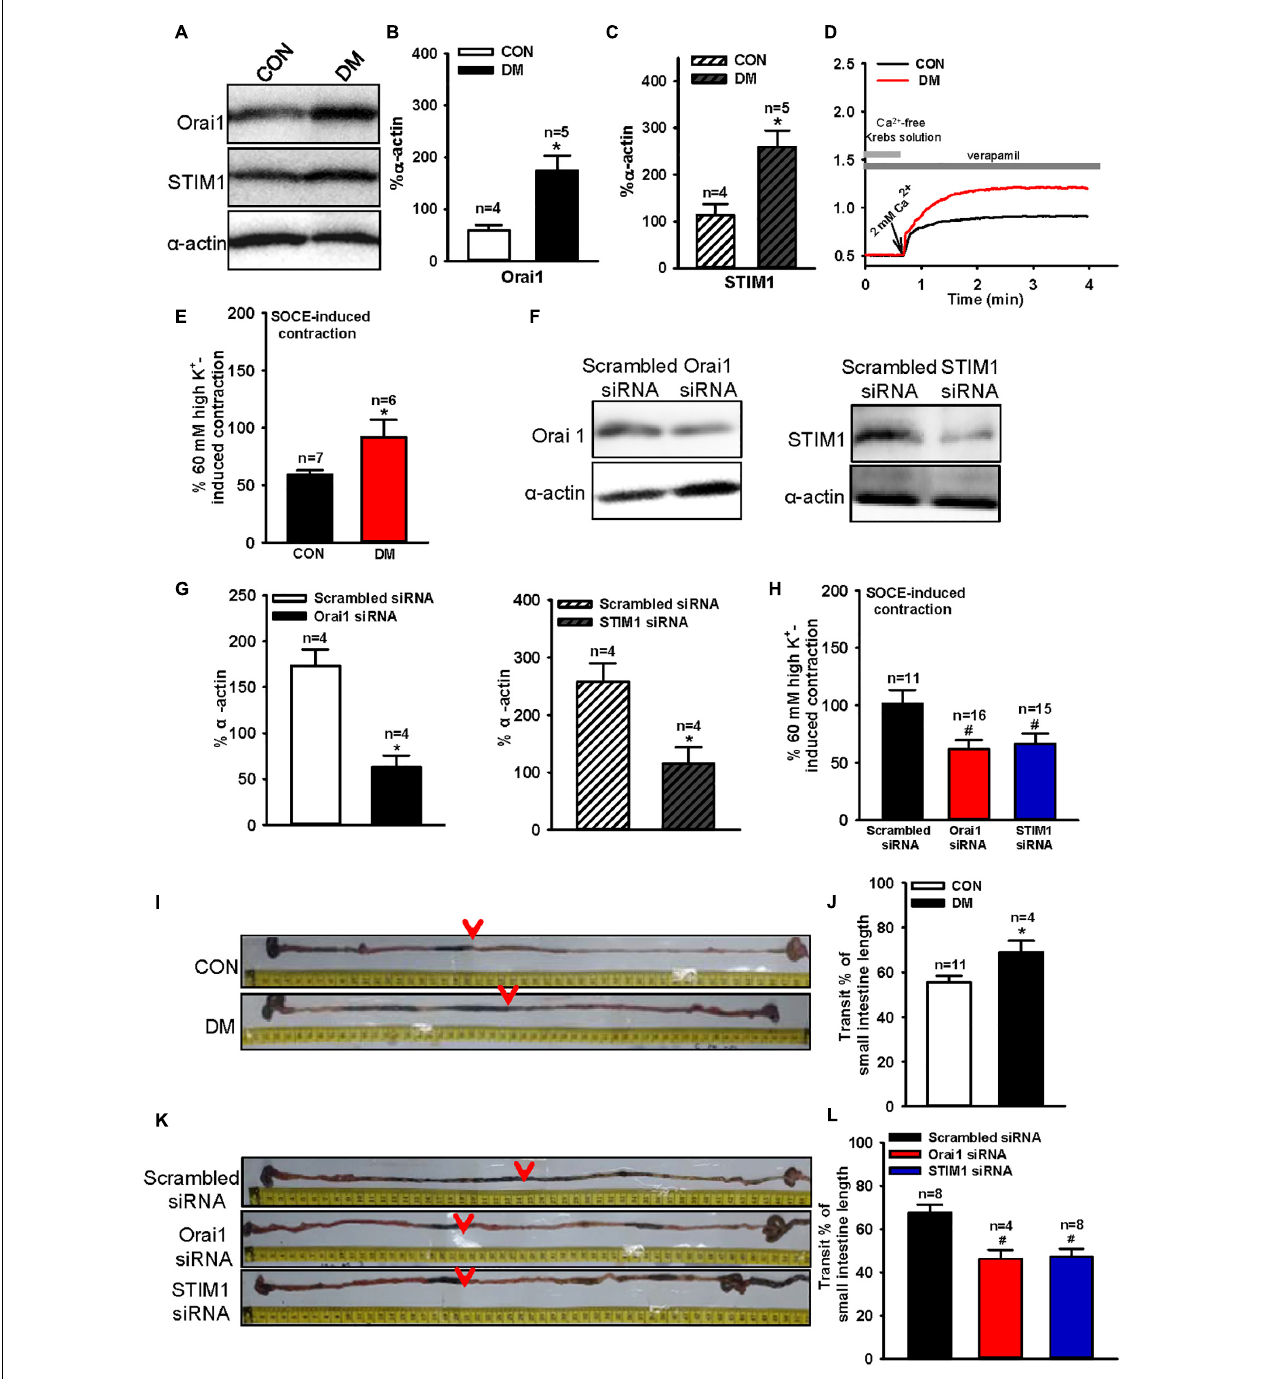
FIGURE 4 | Orai1 and STIM1 protein expression levels, store-operated Ca 2 + entry (SOCE)-mediated mouse small intestinal longitudinal contraction and intestinal transit time alterations in diabetic mice and the effect of Orai1 and STIM1 siRNA transfections. Representative immunoblotting images (A) and summarized data (B,C) showing the expression levels of Orai1 (A,B) and STIM1 (A,C) proteins in small intestinal smooth muscle cells of age-matched control (CON) and diabetic (DM) mice. Alpha-actin was used as a loading control. Values are shown as the mean ± SEM ( n = 4–5); * P < 0.05, age-matched control vs. diabetic mice. Mouse small intestine segments were precontracted by the application of 100 µ M carbachol in Ca 2 + -free Krebs solution to evoke SOCE. Then, re-addition of 2 mM Ca 2 + induced longitudinal contractions of small intestine segments. Representative traces (D) and summarized data (E,F) showing SOCE-mediated small intestinal longitudinal contraction in age-matched control (CON) and diabetic (DM) mice (D,E) . Representative immunoblotting images and summarized data showing Orai1 and STIM1 expression levels in diabetic mice small intestinal smooth muscle cells transfected with Orai1 siRNA or STIM1 siRNA or scrambled control siRNA.